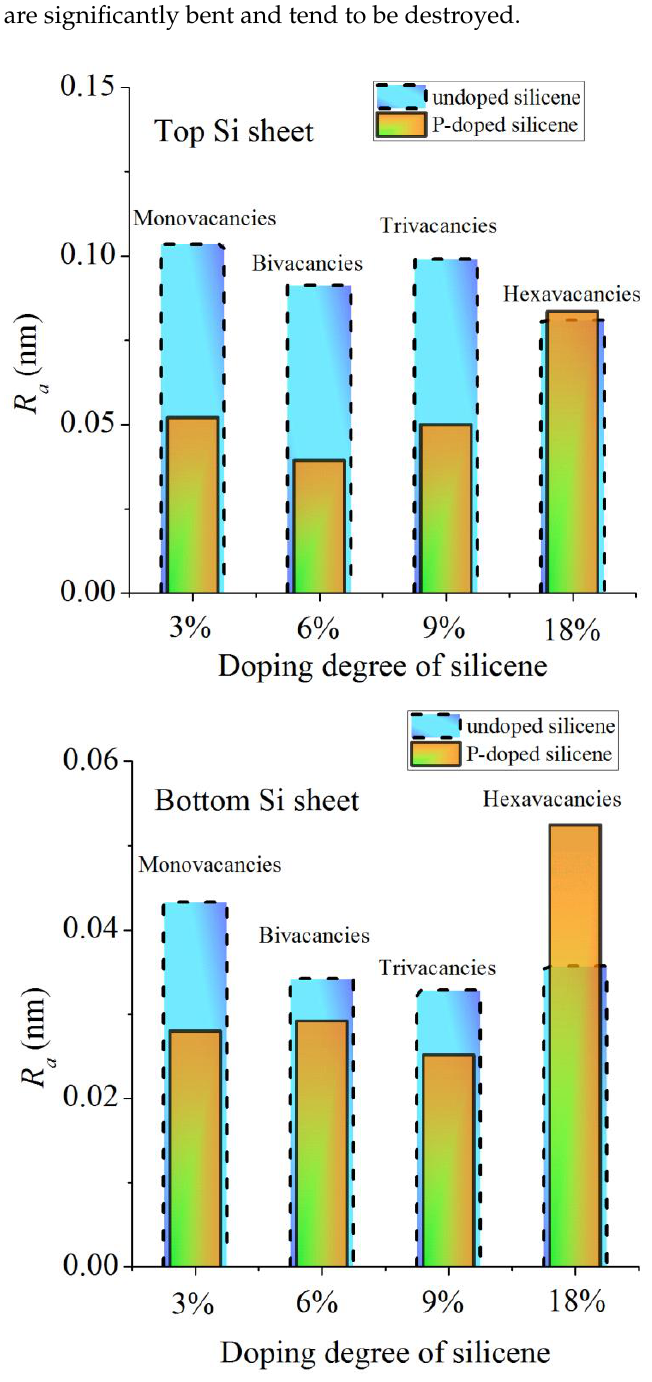
Figure 13. Calculated values of the roughness of the sheets of the silicene channel depending on the degree of doping of its walls with phosphorus (orange bars) or on the size of vacancies (blue bars); the Ni(111) substrates are 5% Cu doped and undoped in the presence of vacancies in silicene, respectively. Adopted with permission from Ref. [39]. 2021, Elsevier.